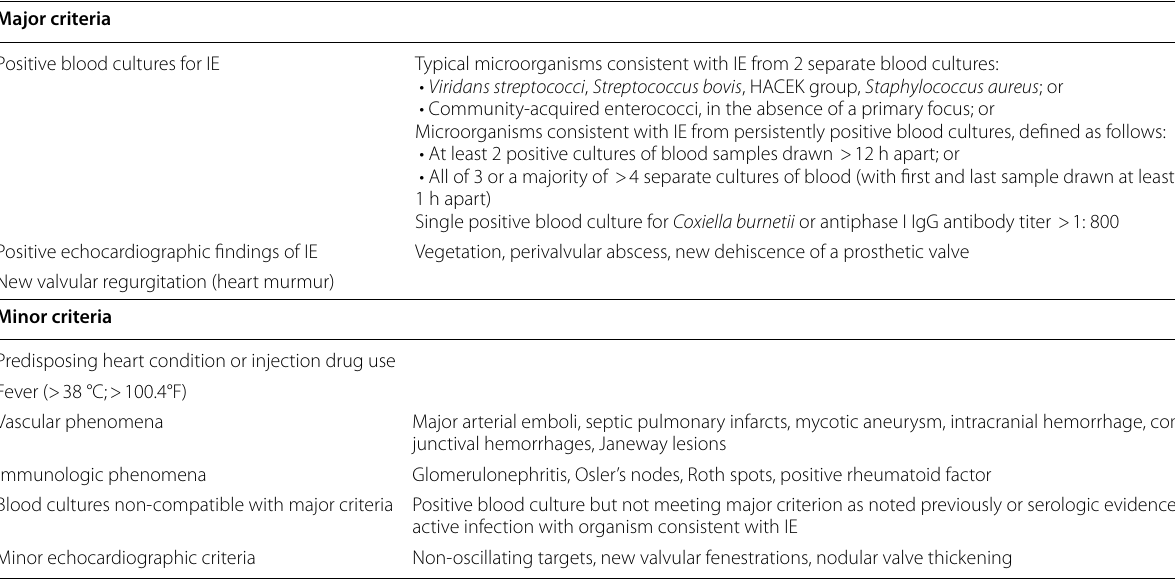
Table 1 Clinical criteria for the diagnosis of infective endocarditis [2, 3]